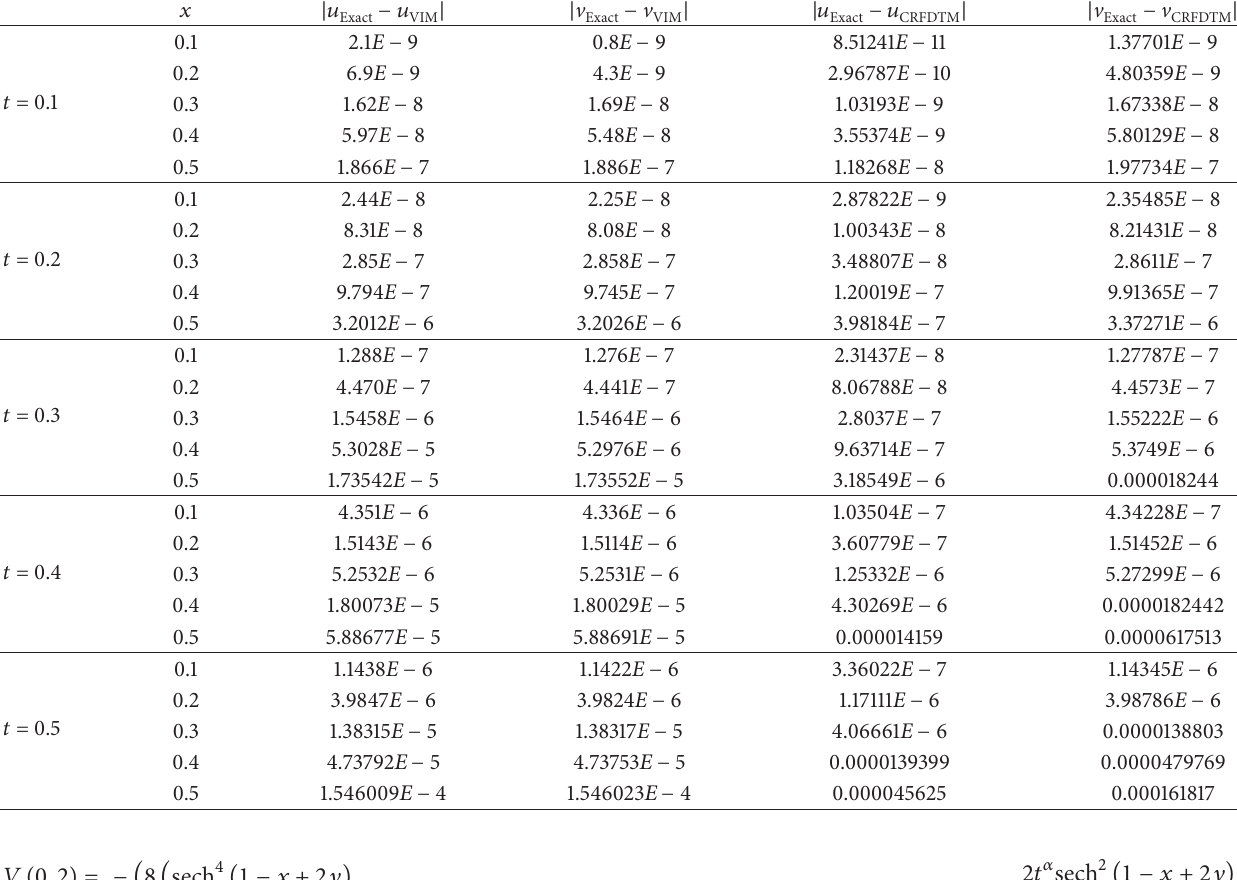
Table 1: The comparison of results obtained in proposed method with VIM when 𝑦 = 1, 𝛼 = 1 , and 𝛽 = 1